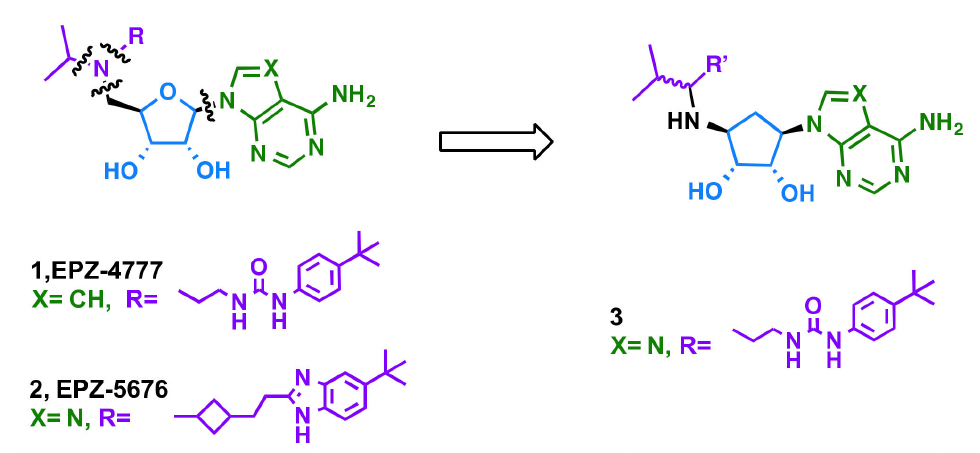
Figure 1. Chemical strategy: the metabolic sensitive points were replaced by more stable fea- tures. In green the adenine scaffold, in blue the sugar, and in purple the side chain specific of DOT1L